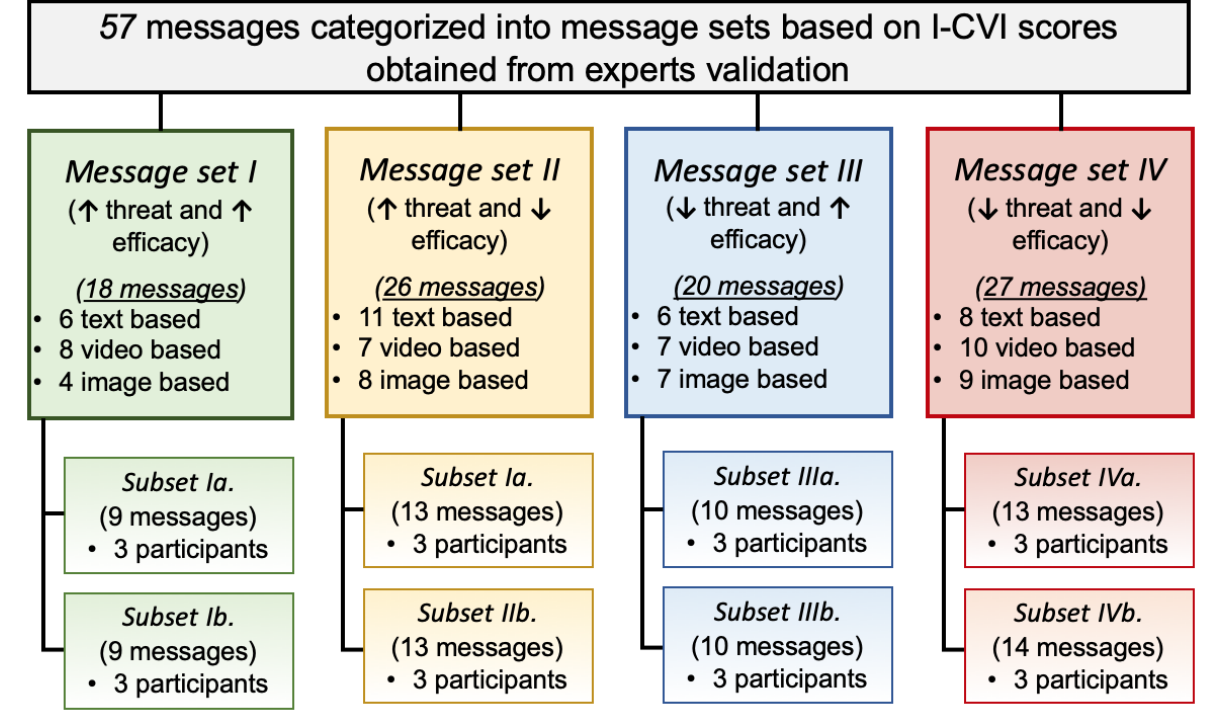
Figure 3. Message sets for perceived persuasiveness testing by patients with obstructive sleep apnea. Some messages were matched with multiple sets based on the obtained I-CVI score. I-CVI: content validity index for